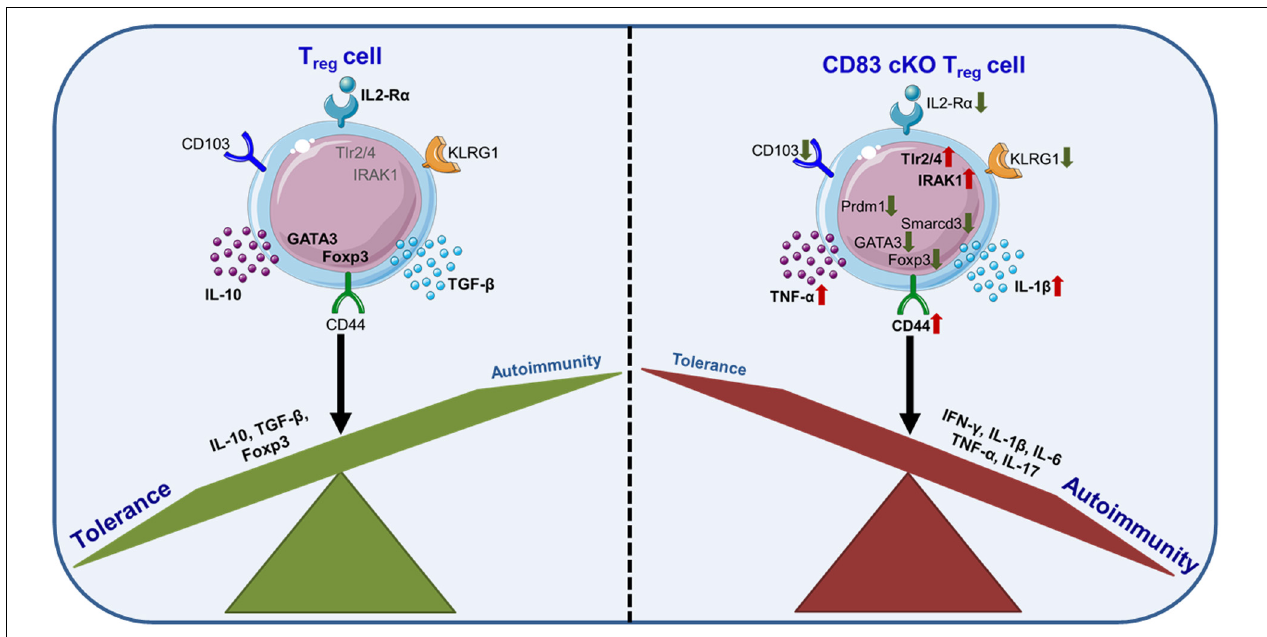
FIGURE 3 | Endogenous CD83 expression is essential for Treg cell differentiation and stability. CD83-deficiency in Tregs results in decreased numbers of differentiated Tregs and less iTregs upon activation. Typical Treg differentiation markers, e.g., CD103, KLRG1 or IL-2R α (CD25), are downregulated,